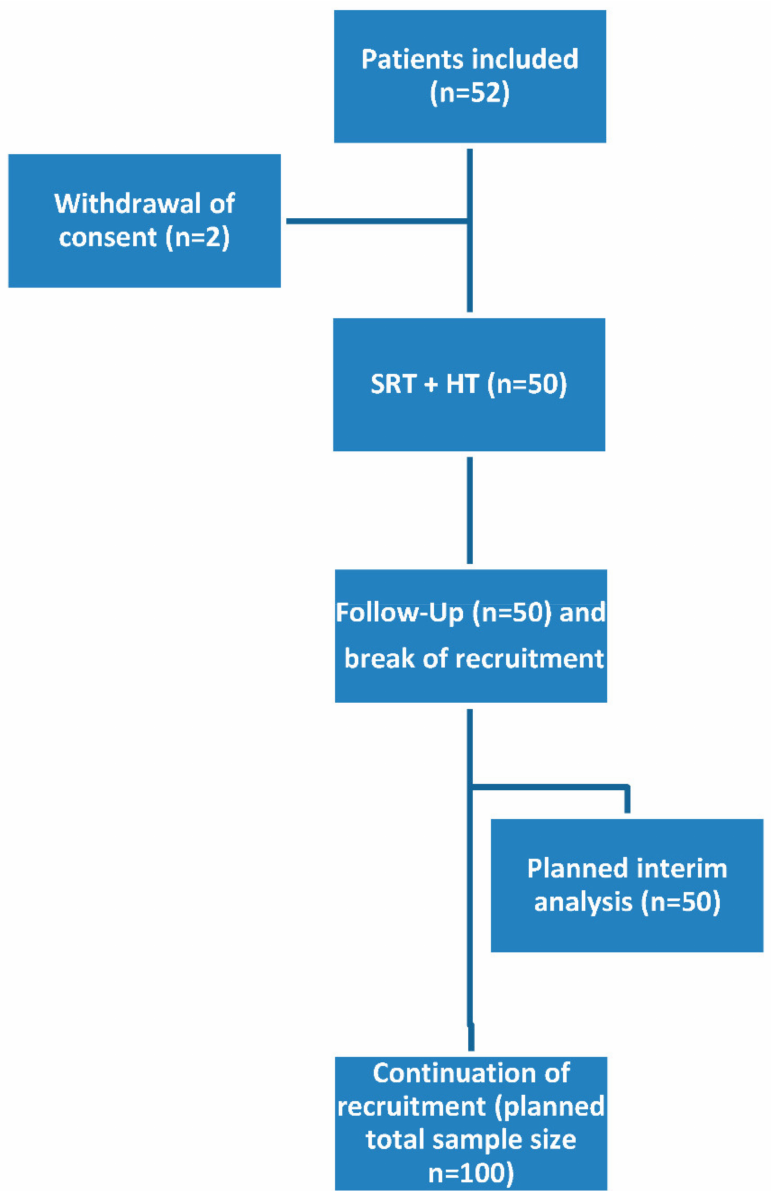
Figure 1. Recruitment schedule (SRT: salvage radiation therapy; HT: